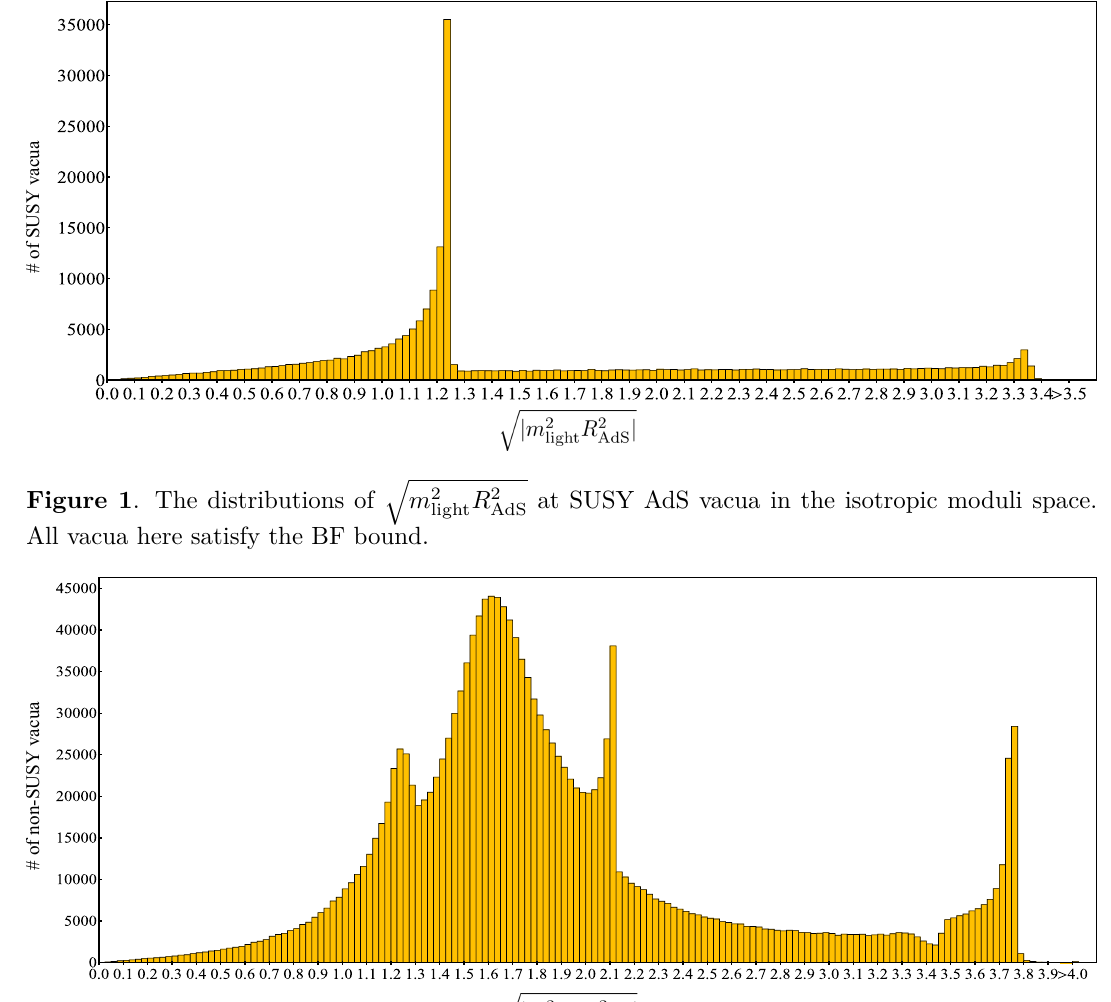
q at non-SUSY AdS vacua in the isotropic moduli space. m 2 R 2 light AdS